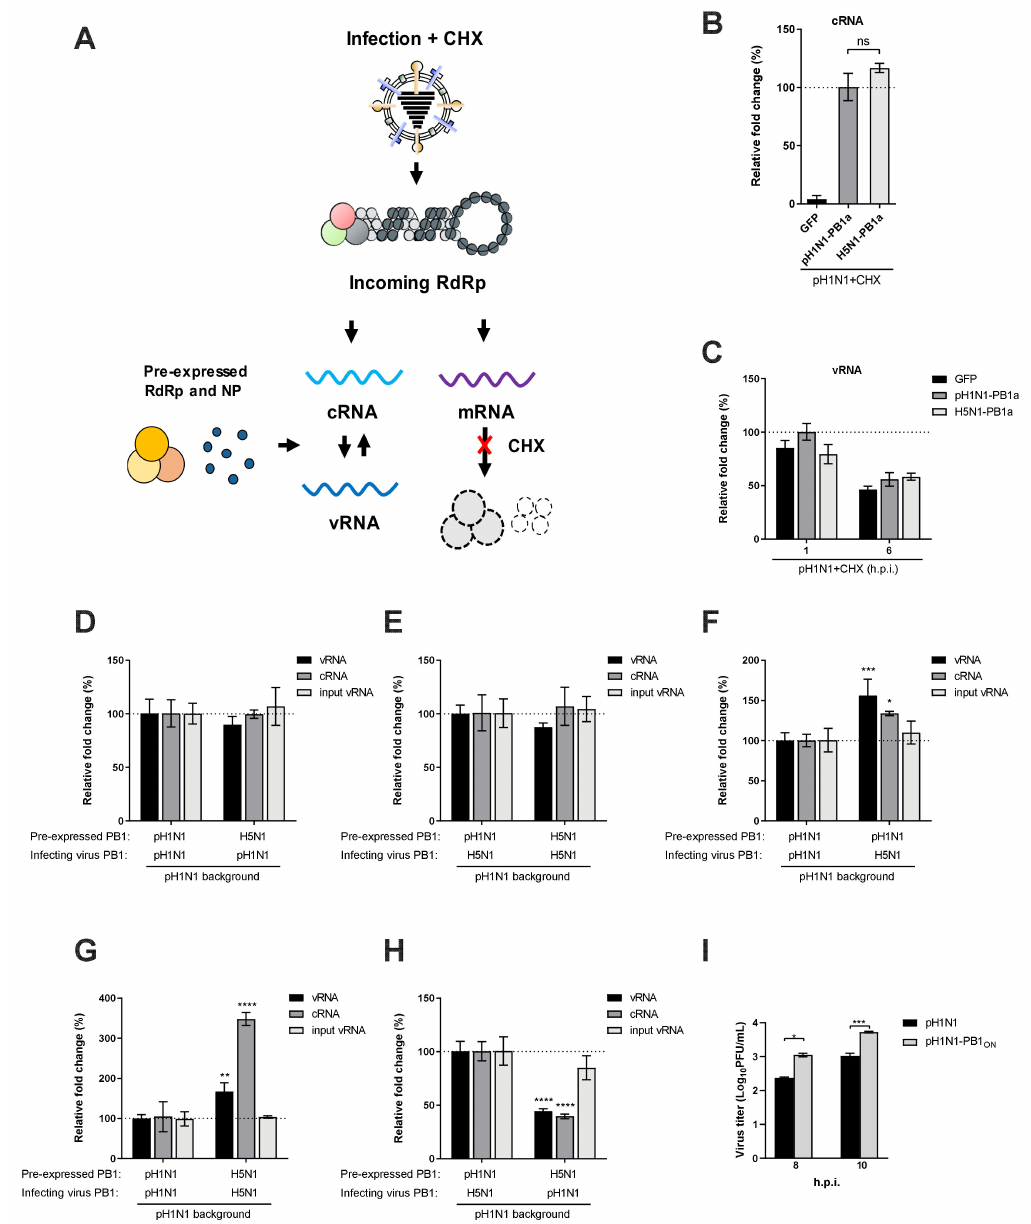
Figure 5. Avian-origin PB1 enhances progeny vRNA synthesis in trans. ( A ) A schematic diagram of the experimental setting. ( B ) 293T cells were co-transfected with plasmids expressing the PB2, PA, and NP of pH1N1 along with a catalytically inactive PB1 (PB1a) of pH1N1 or H5N1. Pre-expression of GFP in place of PB1a served as a negative control. At 24 h.p.t, cells were further infected with the pH1N1 virus at a multiplicity of infection (MOI) of 10 in the presence of cycloheximide (CHX) (100 µ g / mL). Total RNA was extracted at 6 h.p.i, and the levels of complementary RNA (cRNA) were determined by strand-specific qPCR. Relative fold change (%) was normalized to GAPDH mRNA levels and expressed using the ∆∆ Ct method relative to the pH1N1 PB1a condition (set to 100%). ( C ) 293T cells were co-transfected and infected as in ( B ), and the levels of vRNA were determined by strand-specific qPCR at 1 and 6 h.p.i. Relative fold change (%) was expressed relative to the pH1N1 PB1a condition at 1 h.p.i (set to 100%). ( D and E ) 293T cells were pre-expressed with PB2, PA, and NP of pH1N1 along with the PB1 of pH1N1 or H5N1 for 24 h. Cells were subsequently infected with the wild-type pH1N1 virus ( D ) or a recombinant pH1N1 virus containing the PB1 segment derived from H5N1 ( E ) at an MOI of 10